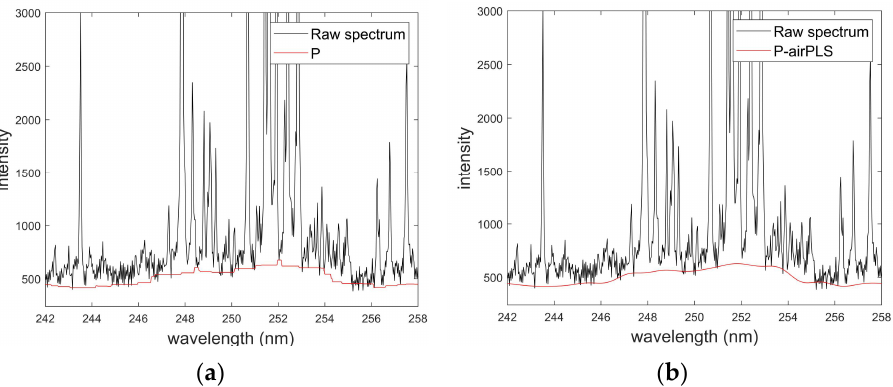
Figure 5. Plot of the baseline correction process. The red line represents the signal processed by different operations. ( a ) Baseline following P operation; ( b ) baseline following P-airPLS method.